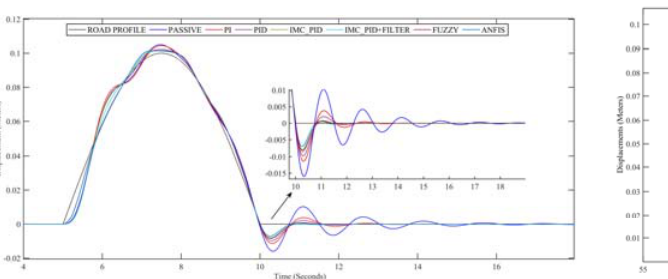
Figure 15. Road profile 2